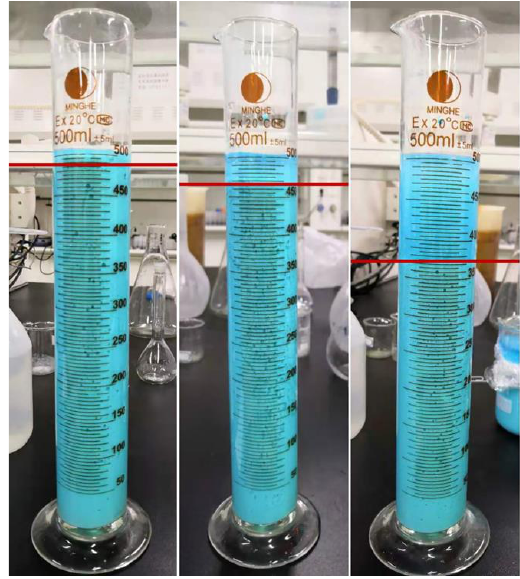
Figure 1. Settling of alkaline copper carbonate particles with